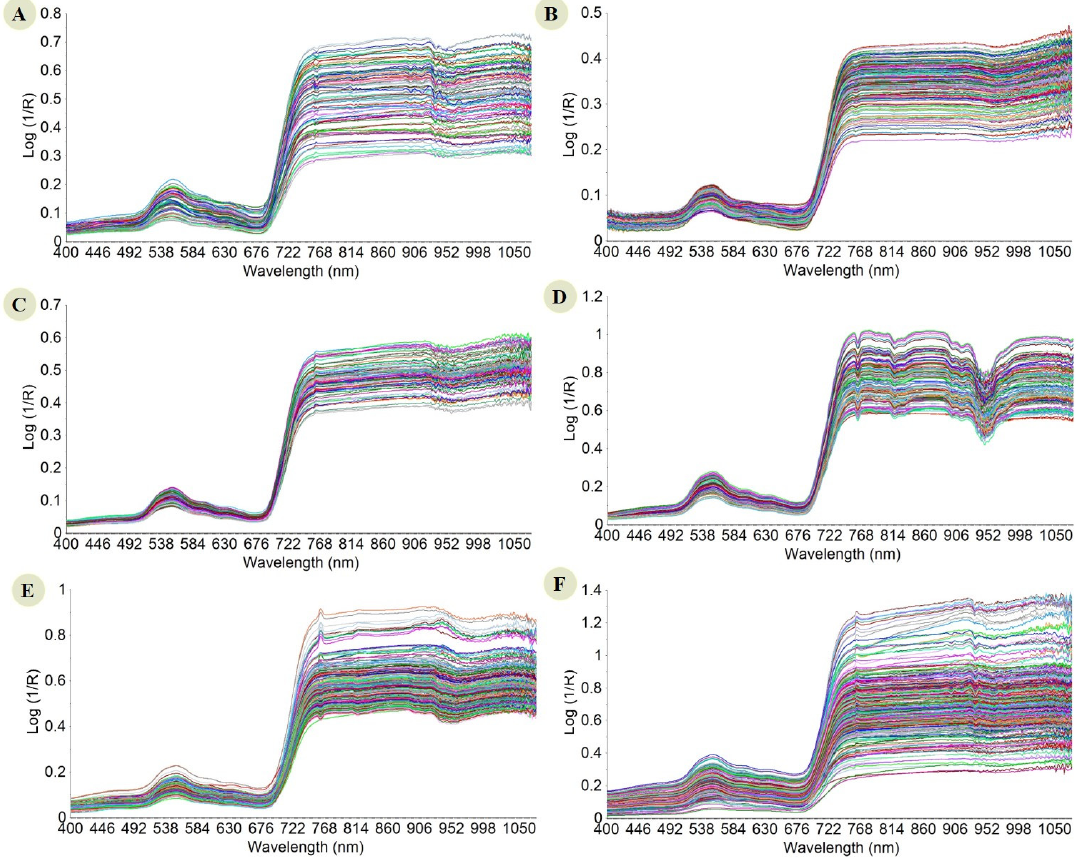
Figure 2. Raw spectra obtained from six Amaranthus sp. in the fields. ( A ): Amaranthus patulus Bertol.; ( B ), Amaranthus spinosus L.; ( C ), Amaranthus lividus L.; ( D ), Amaranthus viridis L.; ( E ), Amaranthus retroflexus L.; ( F ), Amaranthus powellii S. Watson.